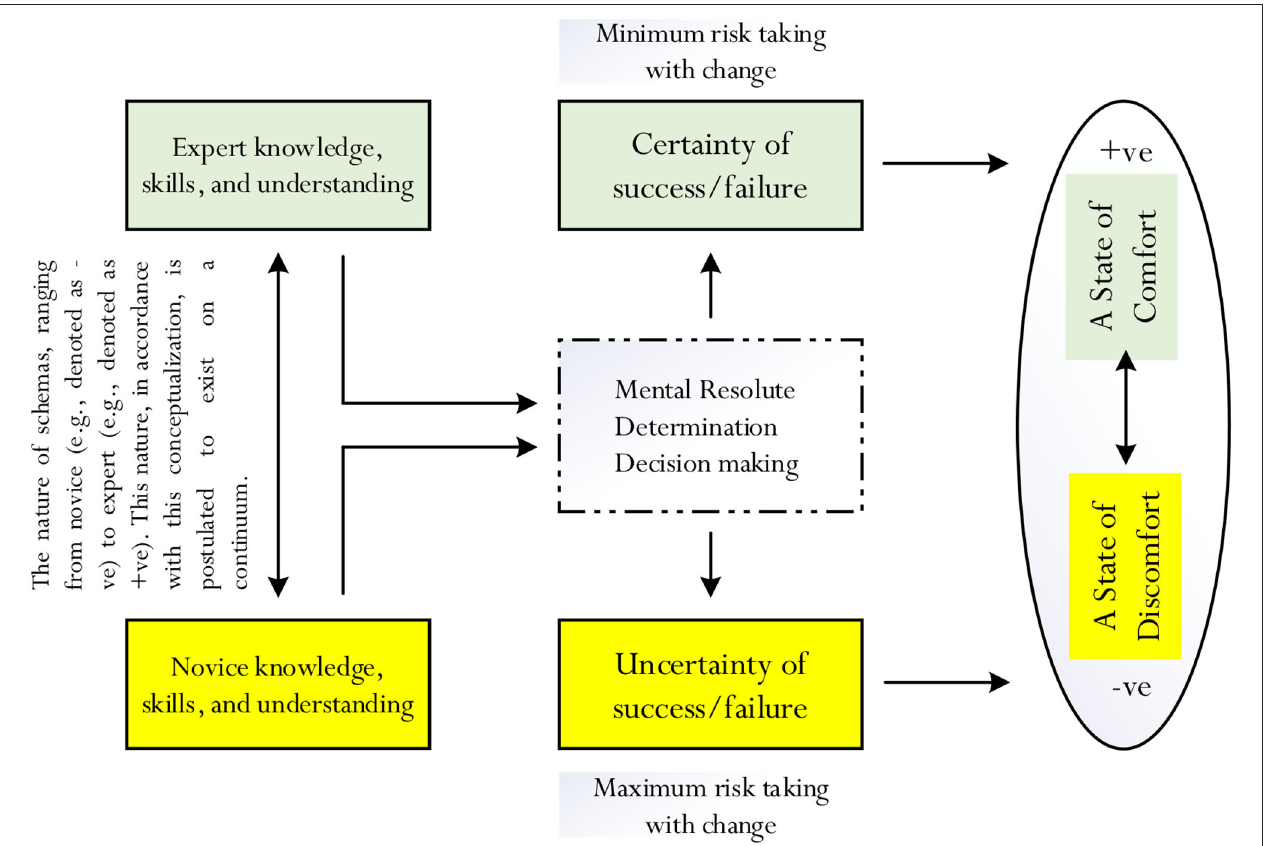
FIGURE 2 | Summary of proposition. This is a summarized depiction of our proposed concept of the zone of cognitive certainty and the zone of cognitive uncertainty. The distinction between expert and novice knowledge is postulated to act as an important driver, which would direct and govern the mental resolute, determination, and decision-making of a person. For example, as identified by the coloring in this figure (i.e., yellow vs. green), a person with expert knowledge, skills, and understanding is more likely to be resolute, determined, and decisive in being certain of his/her success or failure, resulting in the feeling and experience of